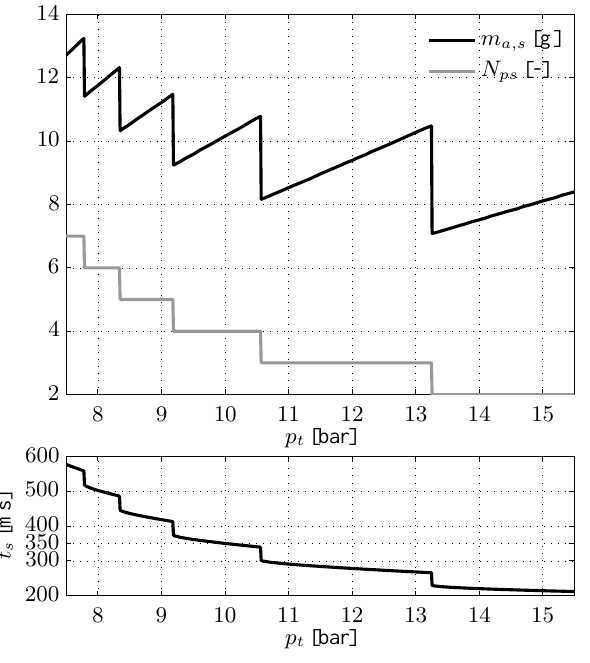
Figure 3. Air consumption m pneumatic start at various tank